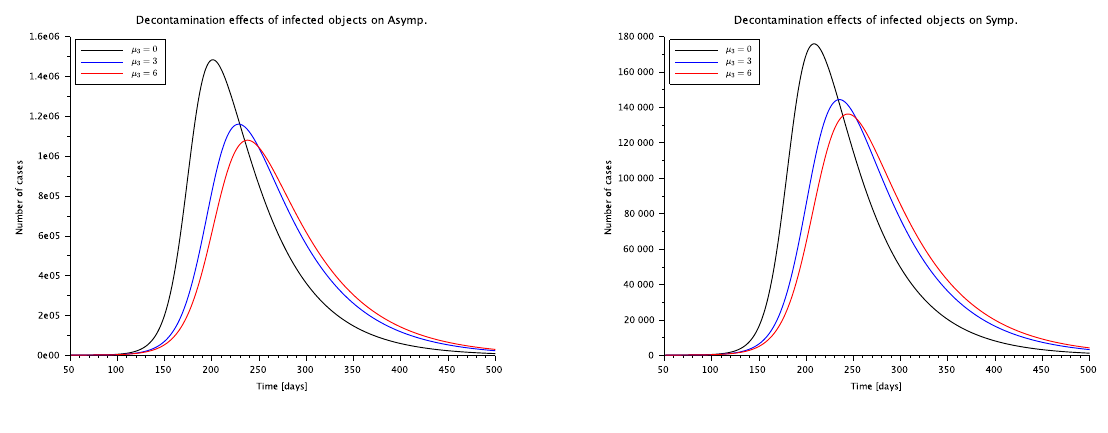
Fig. 1: Number of infected